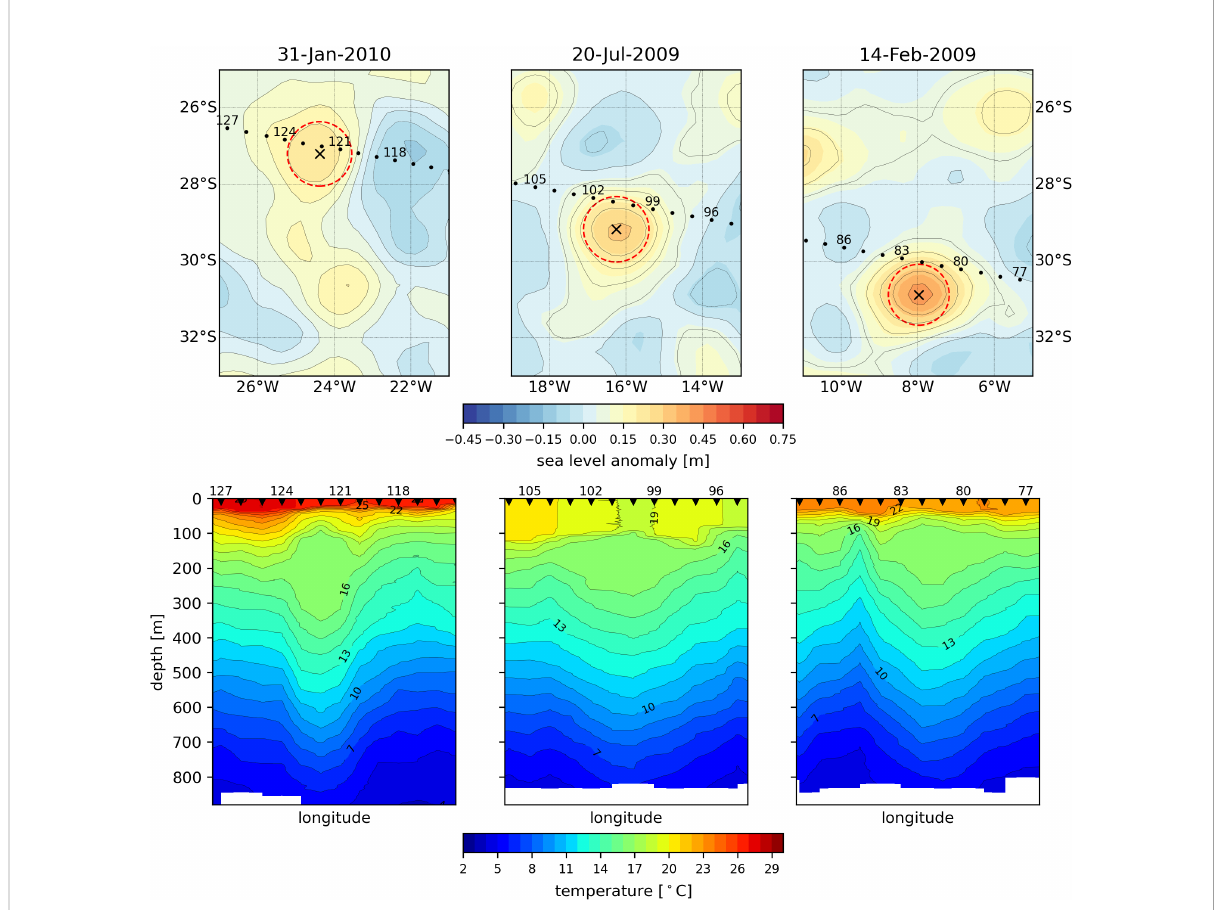
FIGURE 10 Three temperature sections were sampled across the Ring Eliza in successive AX18 cruises in February 2009, July 2009, and January 2019. The top panels show altimetric maps of the ring with numbered deployment stations. The red circle delimits the area de fi ned by one ring radius (93 km, 95 km, and 88 km, from older to younger). The bottom panels show the three temperature